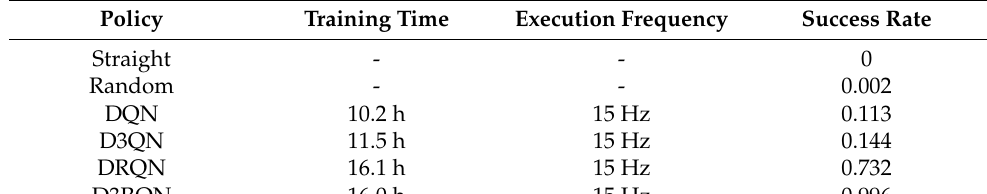
Figure 13. The learning curve of the obstacle avoidance models.